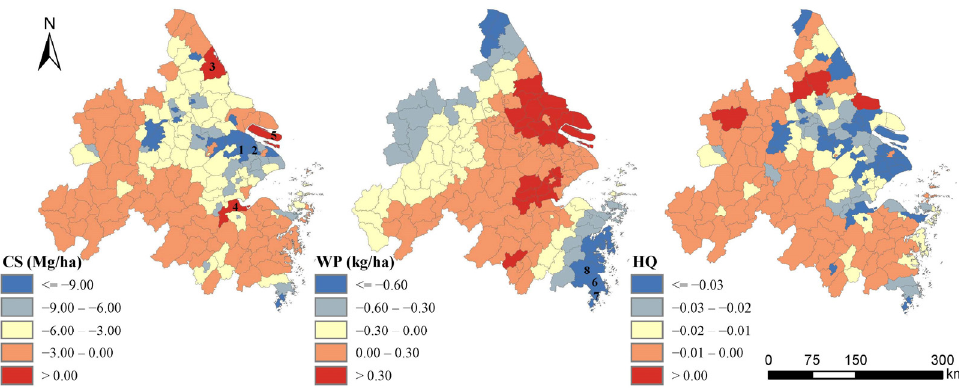
Figure 6. Spatial patterns of ES variations at the county scale in the YRD region (CS: carbon storage;